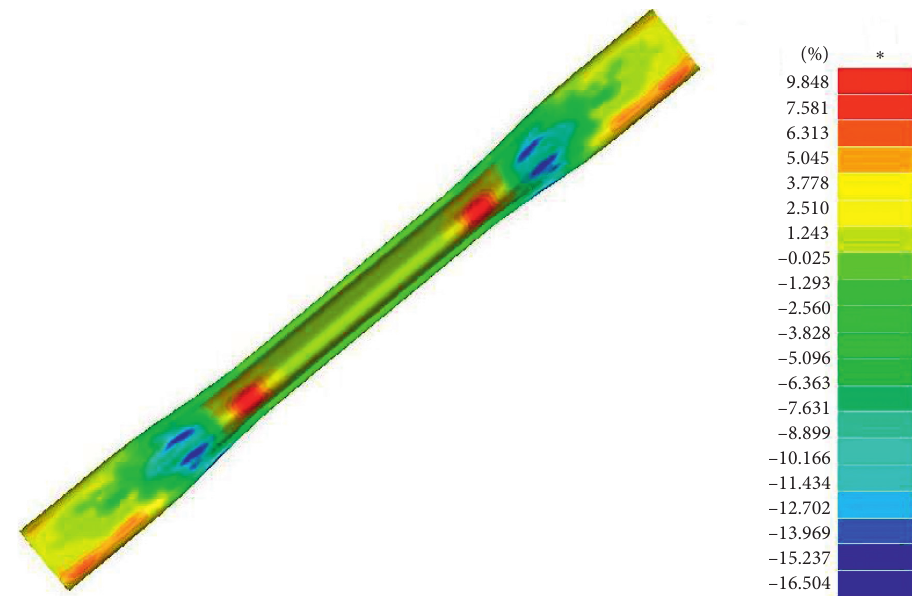
Figure 19: Nephogram of thinning rate of A